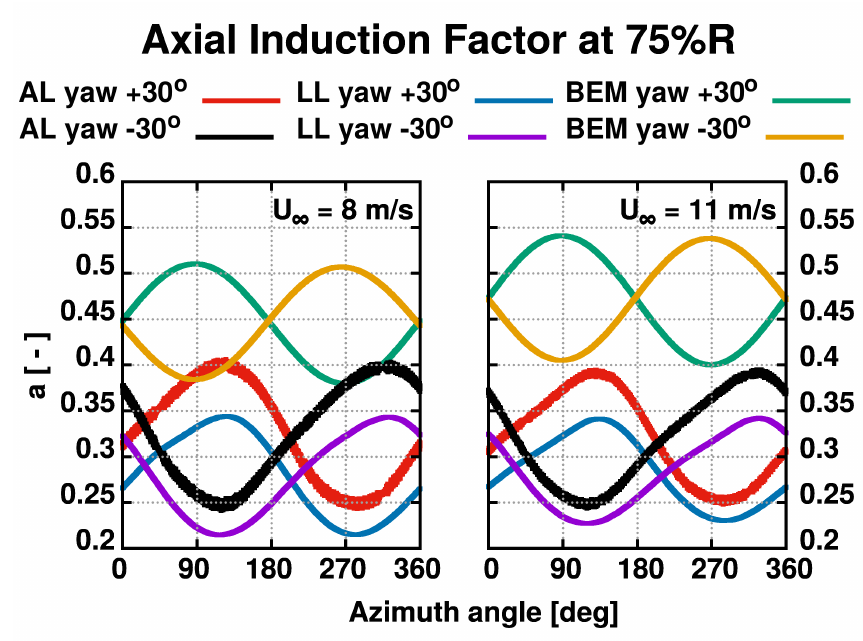
Figure 32. Axial induction factor at 75% R of the blade at 30 ◦ yawed wind speed at 8 and 11